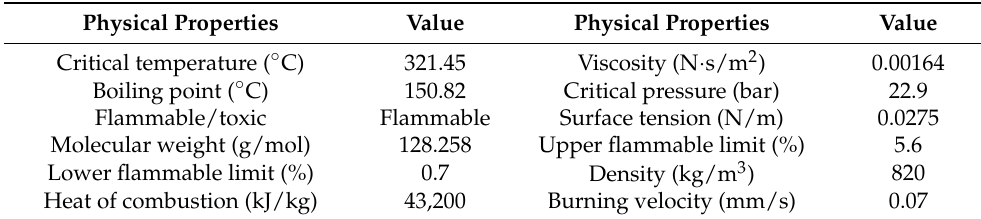
Table 1. Properties of kerosene